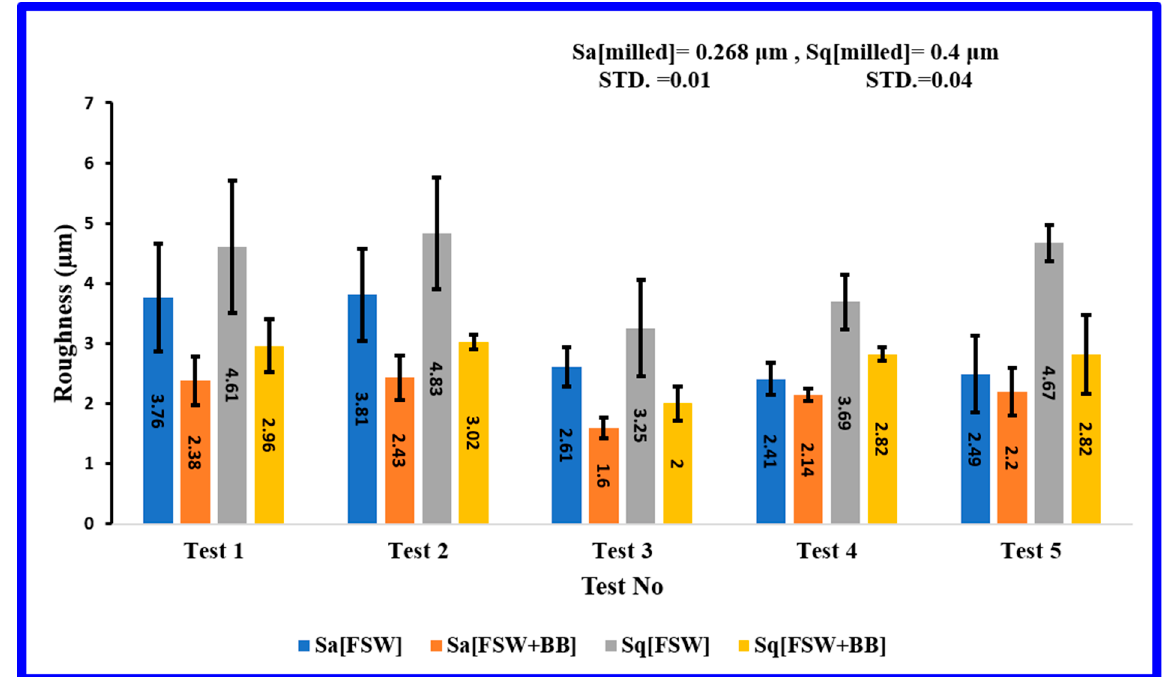
Figure 7. Surface amplitude descriptive parameters with their standard deviation (STD) for the surface (before FSW, after FSW and after BB).